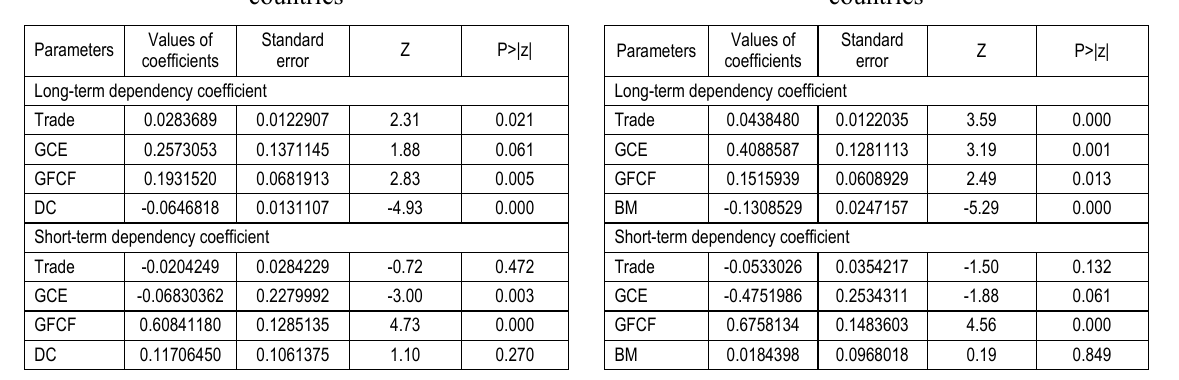
Table 15. The results of PMG approach to determining short-term and long-term